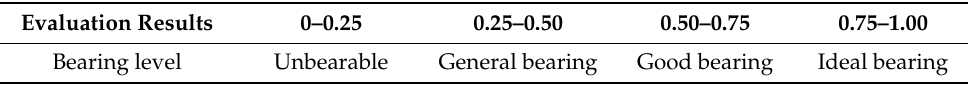
Table 6. Classification criteria of comprehensive score values of water resources carrying